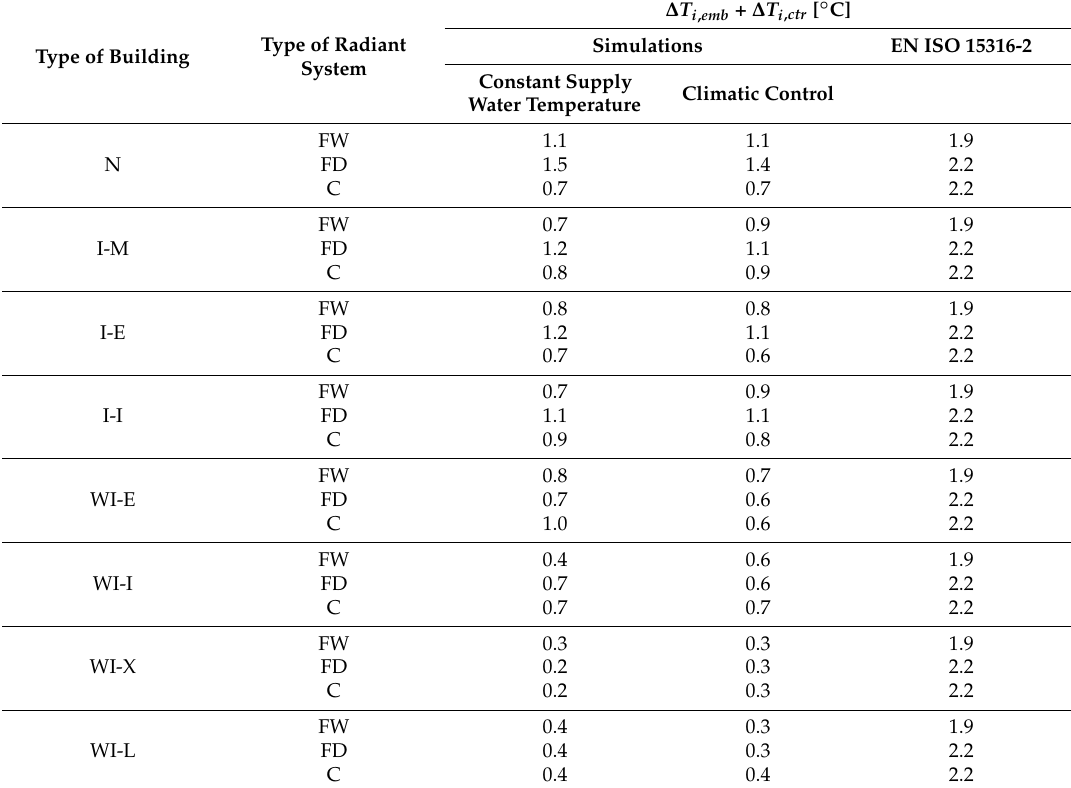
Table 8. Temperature variation values calculated from the results of the dynamic simulations with DIGITHON and values according to EN ISO